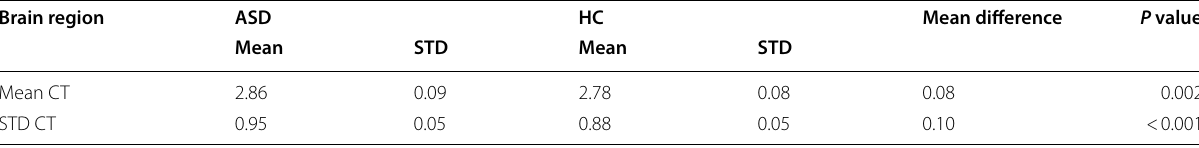
ASD Autism Spectrum Disorder, HC Healthy Controls, STD Standard Deviation, L Left, R Right Table 6 Statistical results of mean and standard deviation of cortical thickness (significant